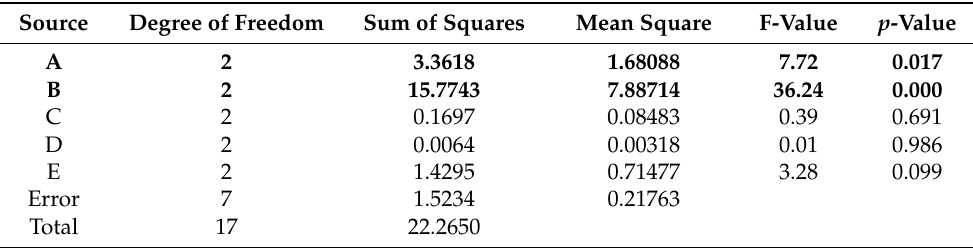
Table 5. Analysis of variance for the S/N ratios of flocculation efficiency during the flocculation of the Bacillus sp. BioSol021 cultivation